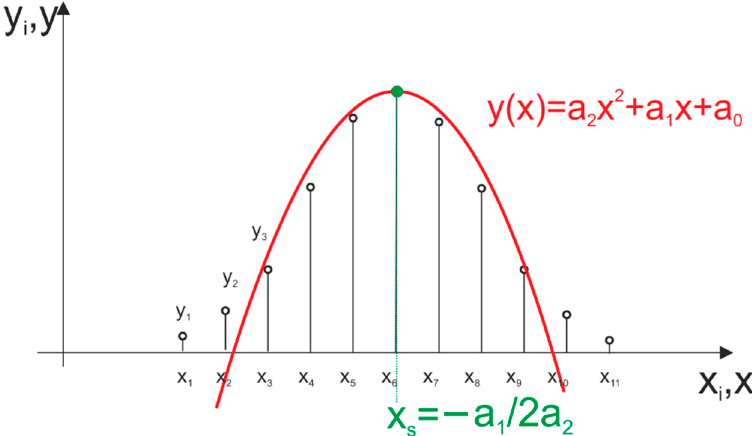
Figure 4. Simple approximation of the discrete echo signal’s waveform with a second degree polynomial (SDPA-S).